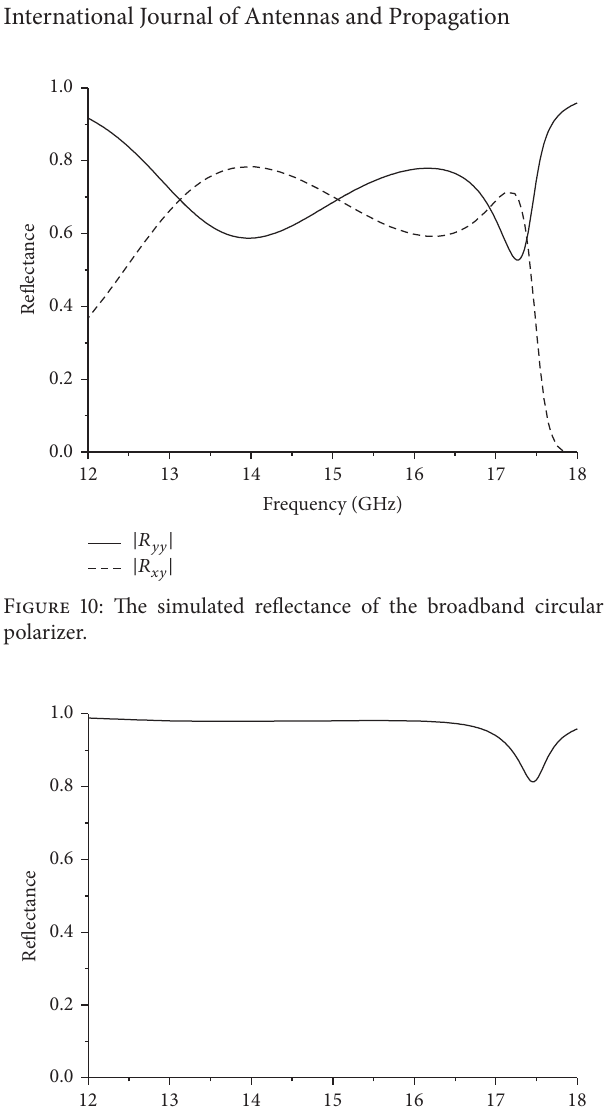
Figure 12: The phase (a) and the phase difference (b) of the 𝑦 - polarized and 𝑥 -polarized